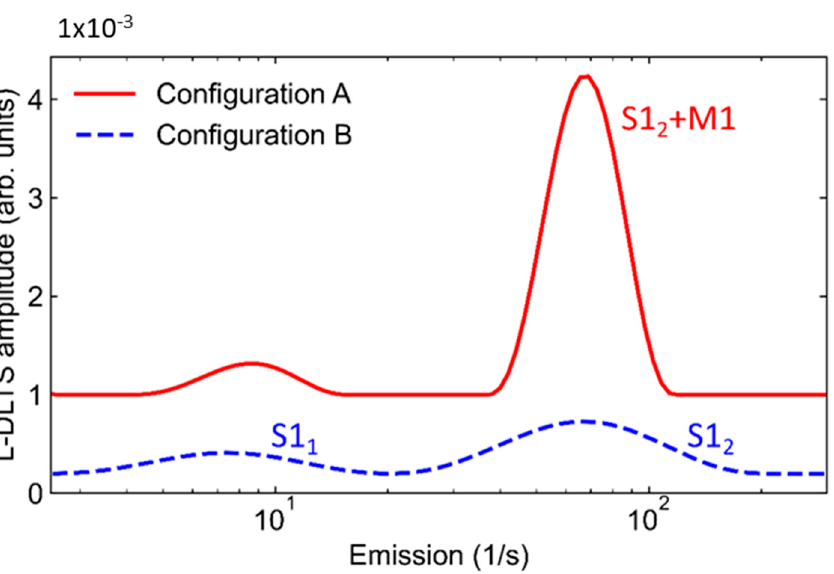
Figure 4. Laplace DLTS spectra for neutron-irradiated samples in configurations A (red, solid) and B (blue, dashed), measured at 210 K.